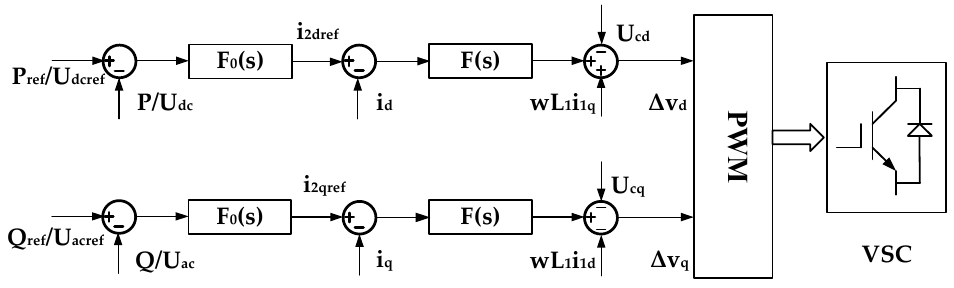
Figure 3. The typical control structure of the inverter.